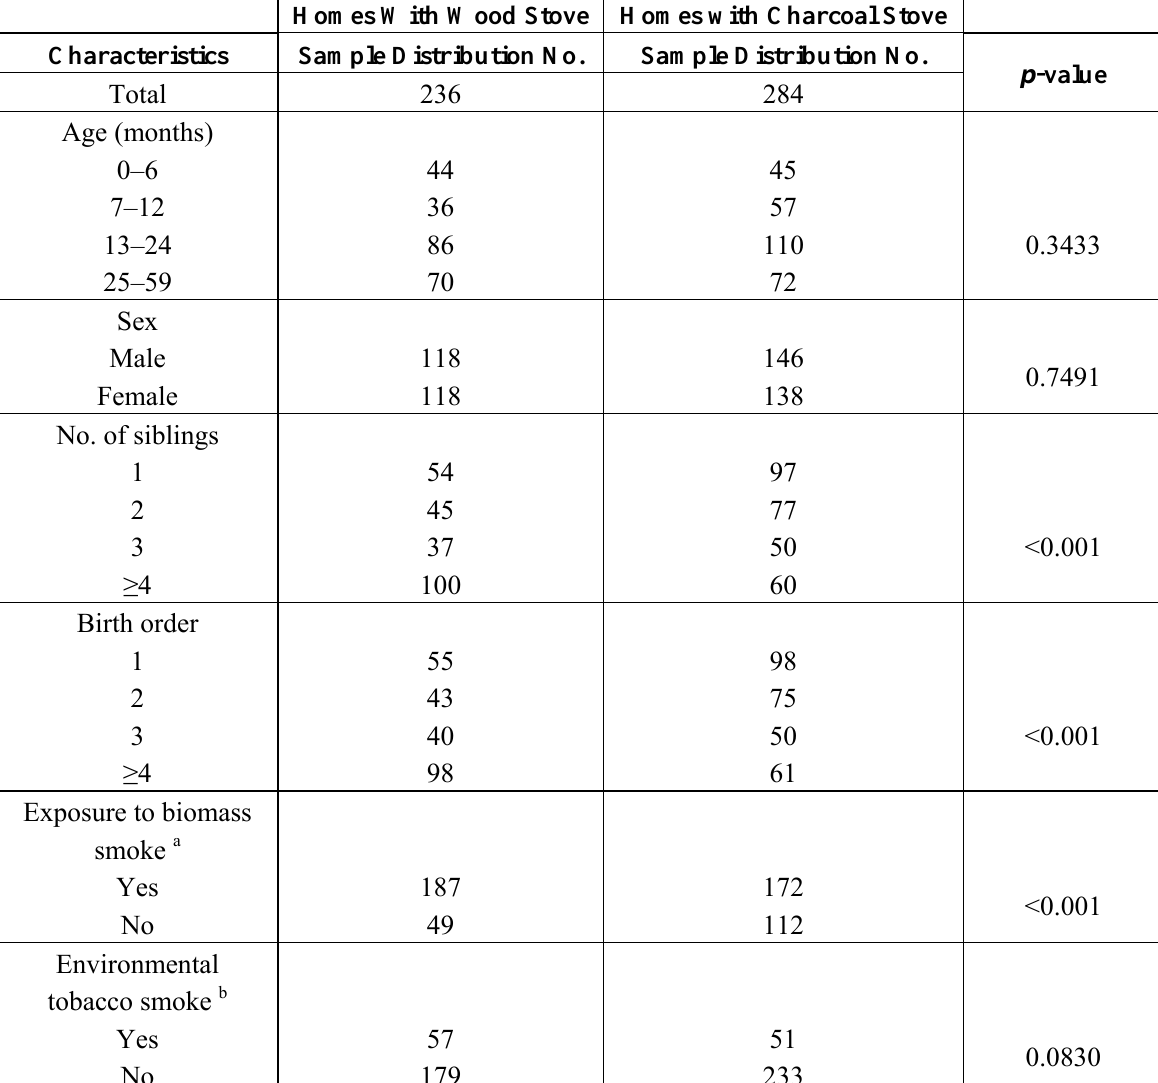
Table 2. Sample distribution of children age 0–59 months by fuel type and other variables. Homes With Wood Stove Homes with Charcoal